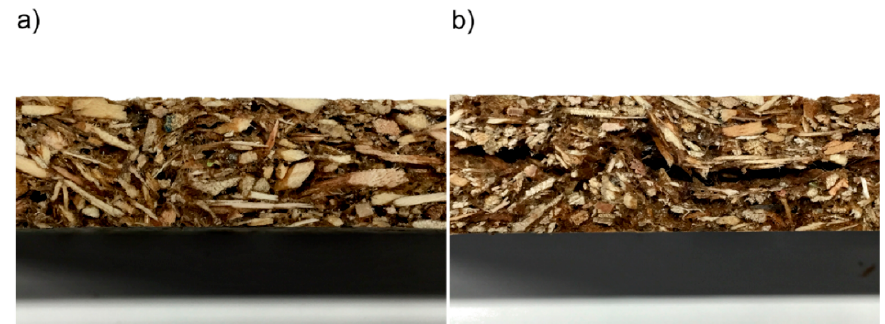
Figure 6. Detail of internal morphology of particleboards: ( a ) expected density of 313 kg/m 3 , showing uniform internal structure; ( b ) expected density of 550 kg/m 3 , showing internal delamination.